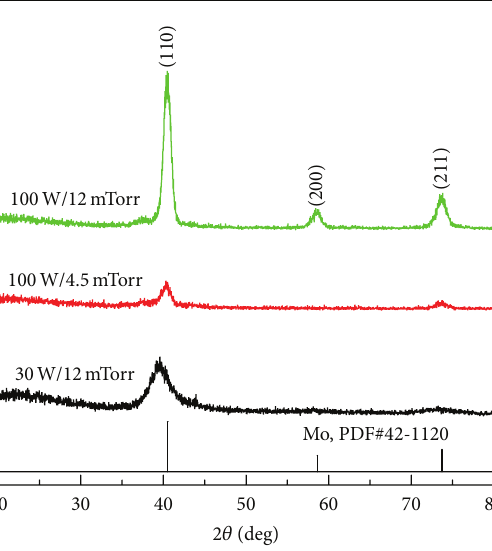
Figure 2: XRD patterns of Mo films prepared at different RF sputtering powers and working pressures: (a) 100W/12mTorr, (b) 100W/4.5 mTorr, and (c) 30 W/12 mTorr.